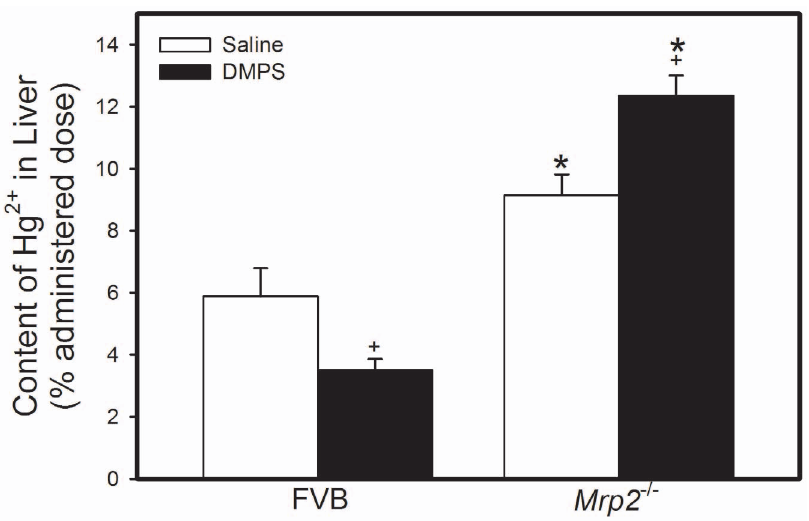
Figure 3. Content of Mercury in Liver of Mrp2 2 / 2 and FVB Mice. Mrp2 2 / 2 and FVB mice were injected intraperitoneally with a dose of 0.5 m mol ? kg 2 1 ? 8 mL 2 1 HgCl 2 . Samples of liver were harvested 48 h after injection with HgCl 2 . Data represent mean 6 SE of liver samples from four mice. *, significantly different from mean of corresponding FVB mice (p , 0.05). + , significantly different from mean of mice from same strain treated with saline (p , 0.05).